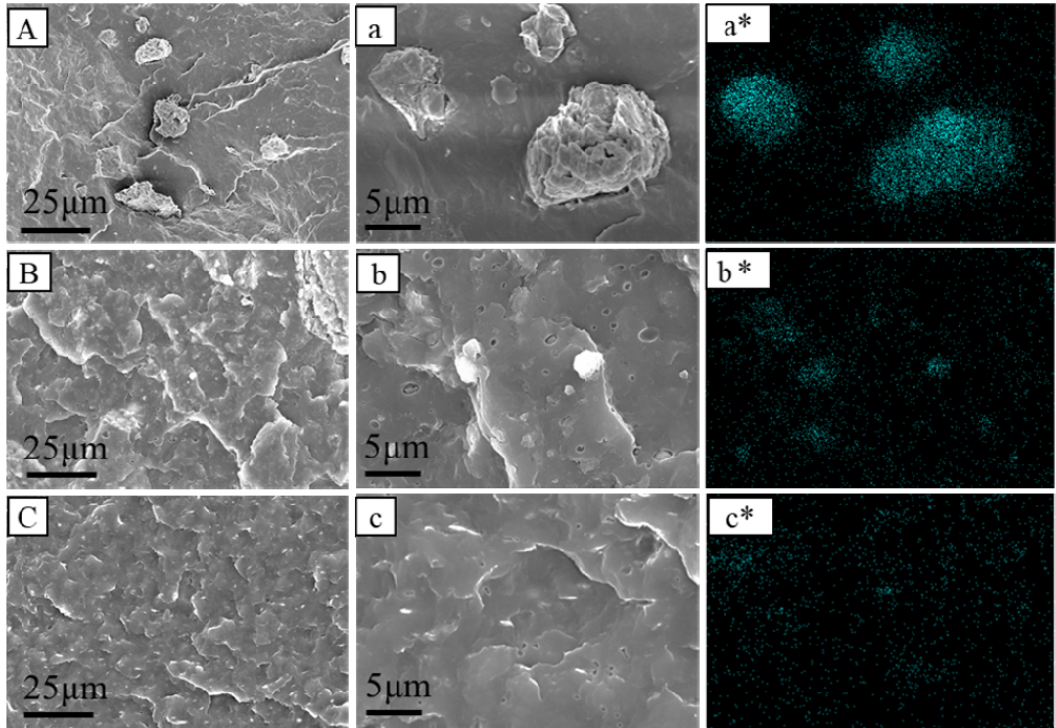
Figure 11. SEM diagram of PP composites. ( A , a ) PP/CaMMT; ( B , b ) PP/TCPP + CaMMT-2/1; ( C , c ) PP/TCPP-CaMMT-2/1; ( a* – c* ) Si distribution mapping.